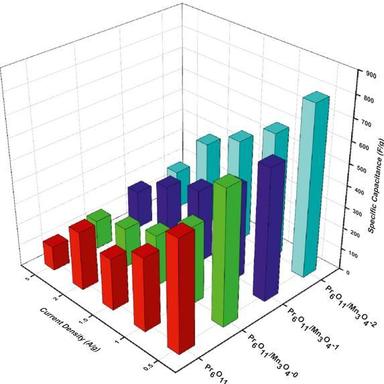
Relationship of specific capacitance with current density of Pr6O11, Pr6O11/Mn3O4-0, Pr6O11/Mn3O4-1 and Pr6O11/Mn3O4-2.